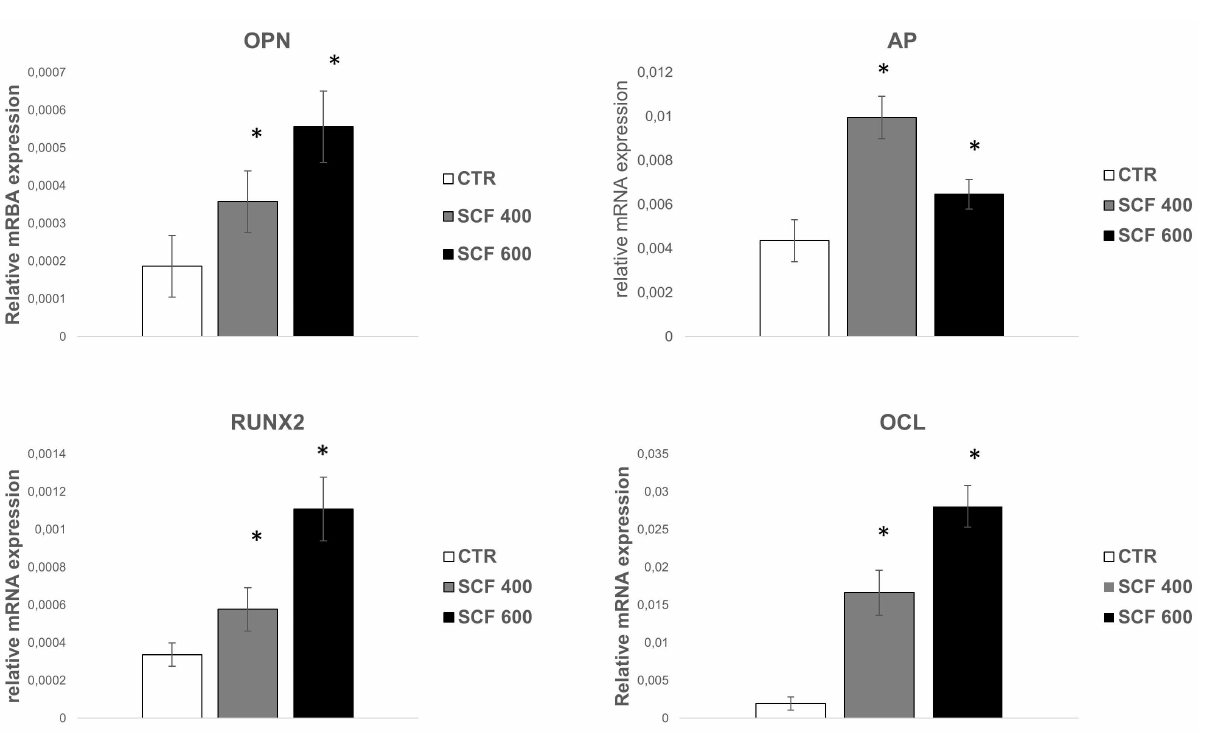
Figure 4. qRT-PCR analysis of the early and late osteoblast differentiation markers’ (RUNX2, AP OPN, and OCL) expression on SAOS-2 cells grown on SCF 400 and SCF 600 scaffolds compared to PLA control (CTR). * identify statistical significance ( p < 0.05). Data are shown as mean